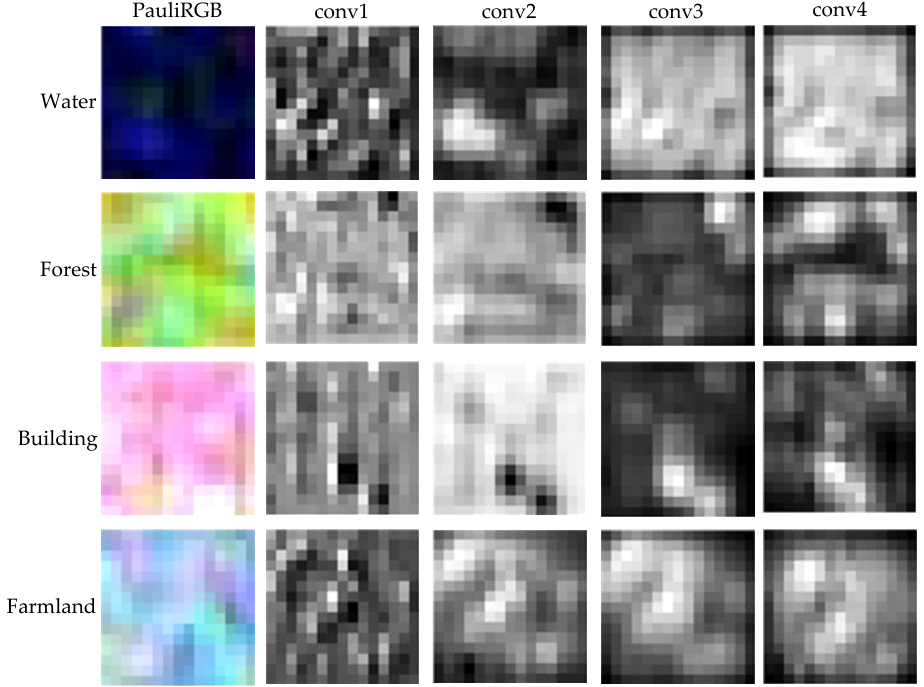
Figure 13. The Pauli RGB images and visualizations of four convolutional layers of water, forest, building and